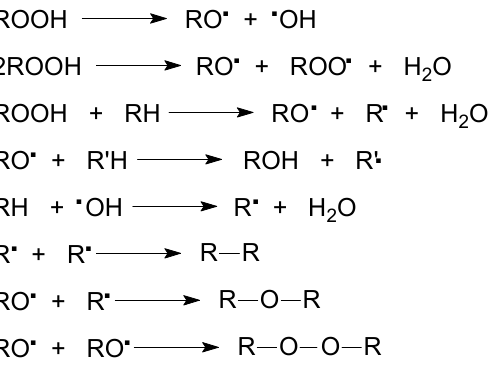
Figure 11. Oxidative cross-linking of polymers from linseed oil-based monomer (LSM). The main mechanical characteristics of films from latex polymers based on styrene or methyl methacrylate and the POBMs were determined. The composition of the copolymers was calculated from the 1 H-NMR spectroscopy data. The content of the olive and soybean monomers in the reaction mixture varied from 10 to 40 wt. % for copolymers with methyl methacrylate and from 25 to 60 wt. % for copolymers with styrene. A plasticizing e ff ect and enhanced hydrophobicity were observed for